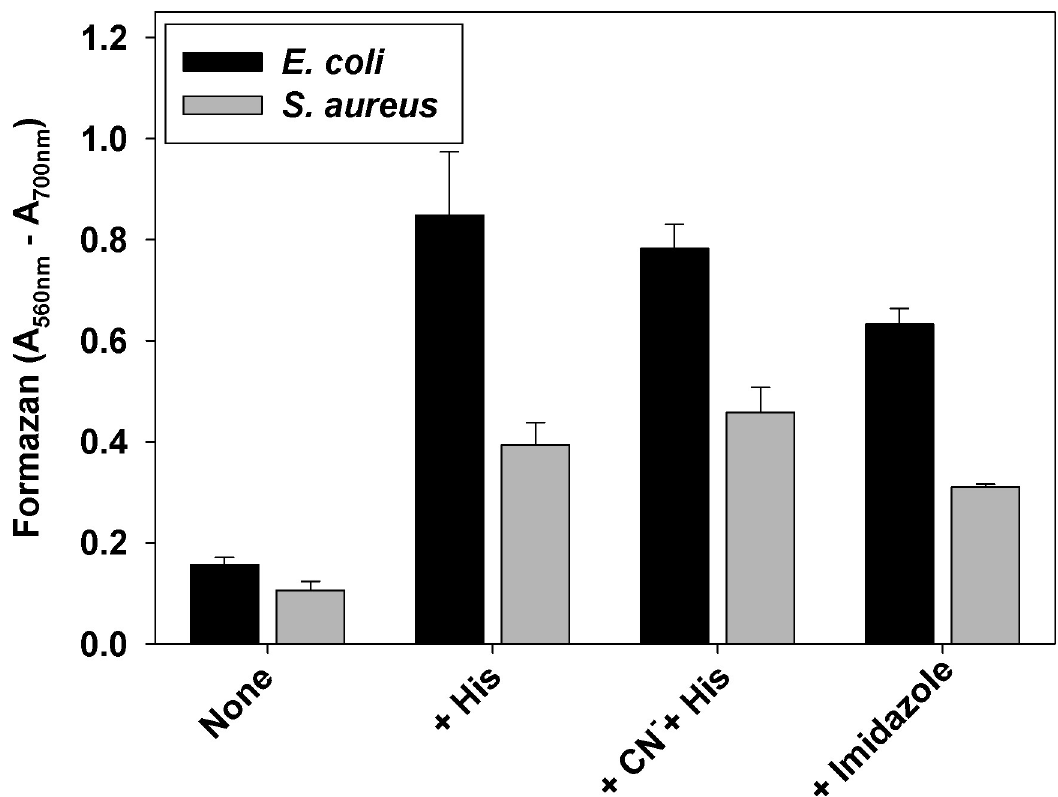
Fig 7. Effect of histidine on MTT reduction under anaerobic conditions. E . coli and S . aureus cultures were grown aerobically to mid-log phase in LB/BHI media respectively. Cells were washed and resuspended in PBS/glucose. The cell suspension was aliquoted in 96-well plates and transferred to anaerobic Coy chamber. The cultures were equilibrated, and degased solutions of histidine (5.0 mM), KCN (5.0 mM), or imidazole (5.0 mM), were added, followed by addition of MTT solution to all wells. After 60 min of incubation at 37 o C, SDS solution was added, plates were taken out, and absorbance at 560 and 700 nm was measured. The average of the difference A 560 nm -A 700 nm of two separate experiments, each sample run in triplicate, ± SD is presented.